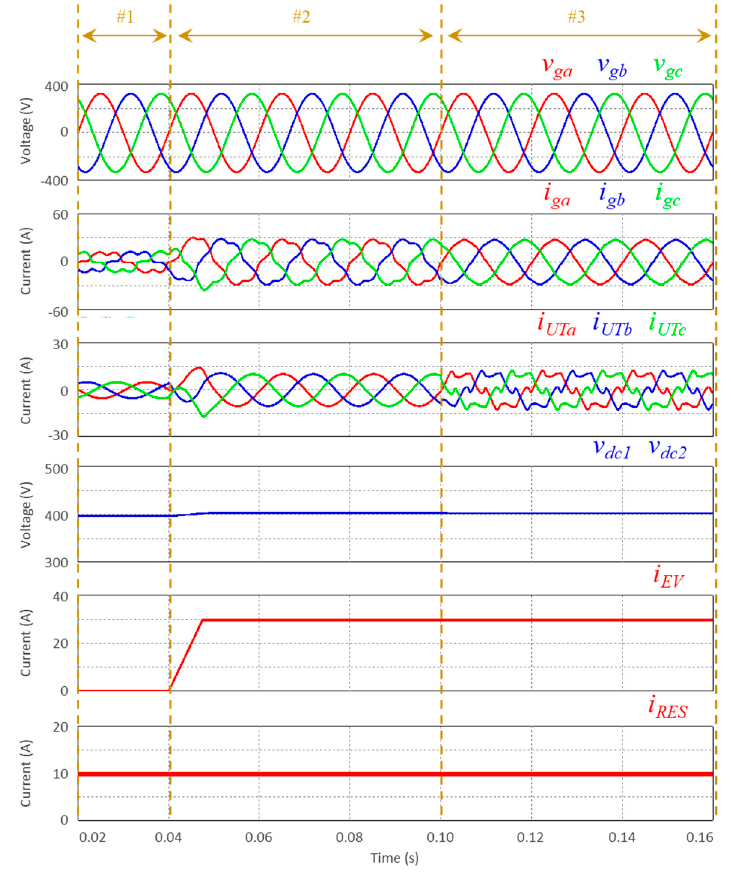
Figure 4. Dynamic operation of the unified topology considering the operation of the EV during the charging process, the operation of the RES injecting power to the power grid, or to charge the EV, together with the active filtering for the power grid.